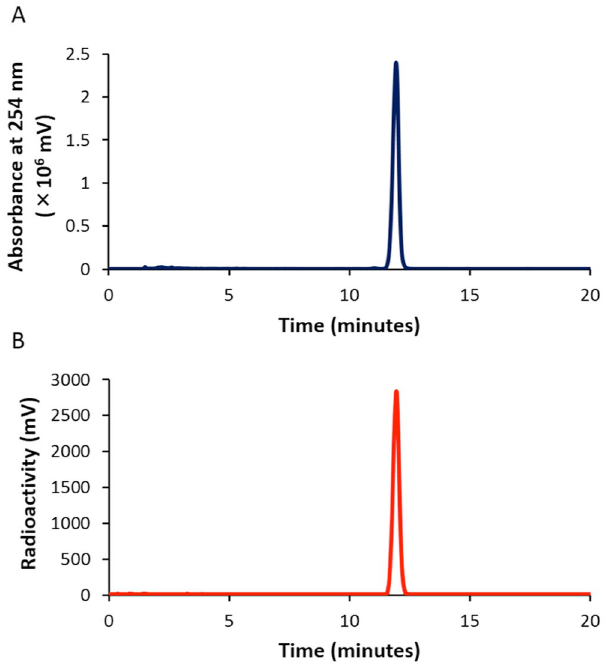
Figure 3. HPLC profiles of 2 (absorbance at 254 nm, A ) and [ 125 I] 2 (radioactivity, B ).